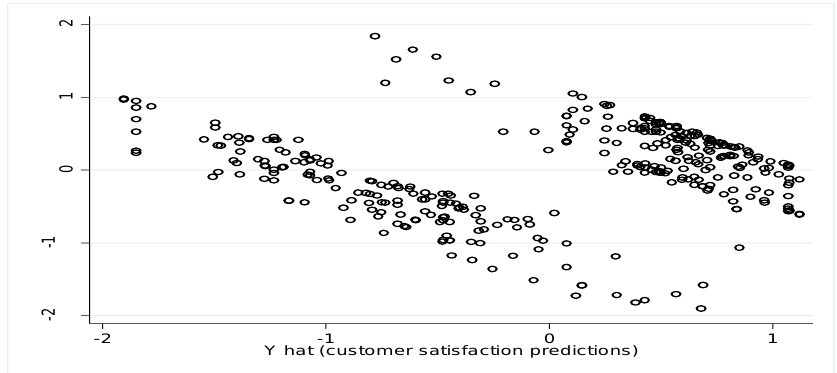
Figure 7: Scatter plot of residuals against predicted values for level-1 residuals; Assurance Customer satisfaction model To further assess homogeneity of variance in the residuals of this model, the EB level-1 residuals were assessed by plotting and displaying a line-up of residual plots associated with each panel (insurer). There are panels that show random plots with no decreasing or increasing linear patterns of the scatter plots to imply homogeneity at these clusters rather than in the entire sample (Figure 8). There are, however, some panels that show a similar decreasing pattern to imply heterogeneity in the residuals even at the panels.